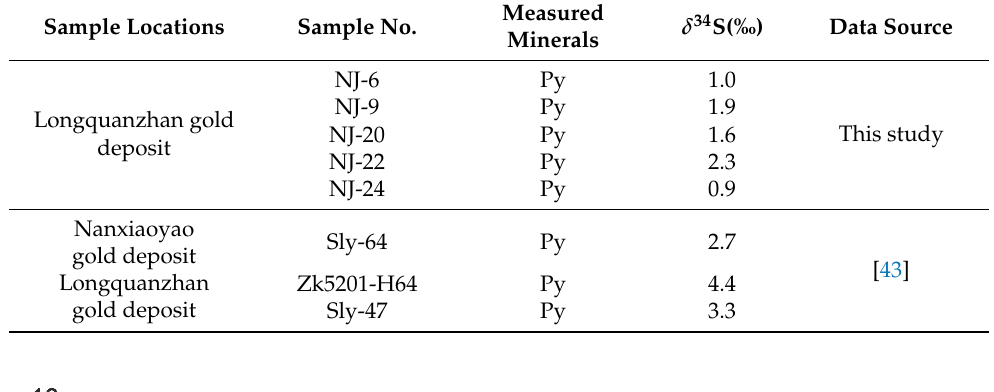
Table 3. Sulfur isotopic compositions of sulfides from the Longquanzhan and Nanxiaoyao gold deposits in the Tan-Lu fault zone.